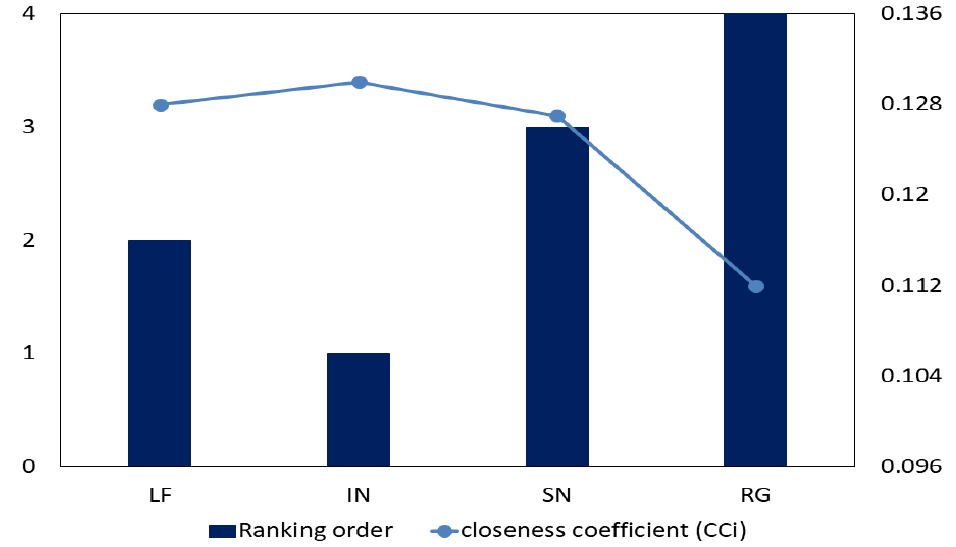
Figure 3. The final ranking of the closeness coefficient of the alternatives.